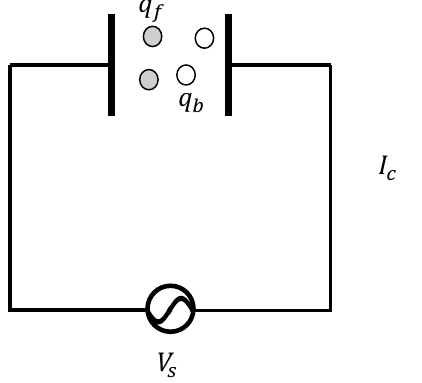
Figure A4. Conceptual illustration of conduction and displacement currents in an air-gap in an Alternating Current (AC) circuit. The conduction current is carried by free charges (filled circles) and displacement current is carried by bound electrons (open